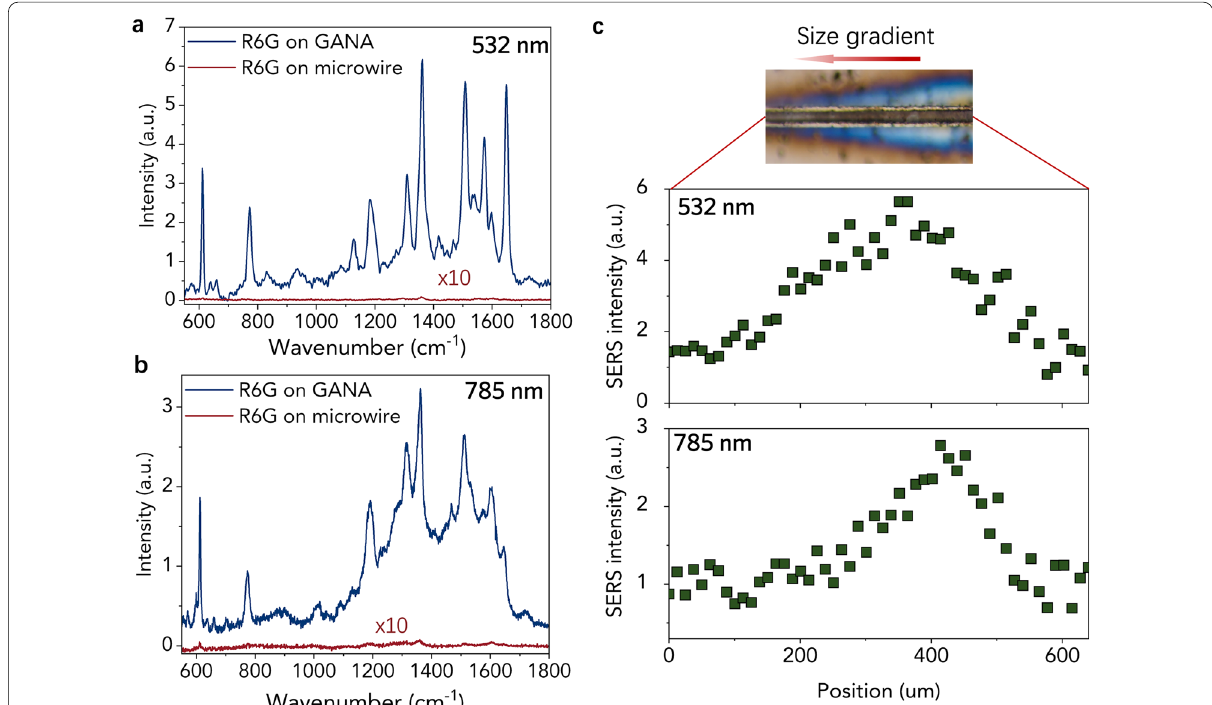
Fig. 5 Typical SERS spectra of R6G on microwire with and without gold GNPA at a 532 nm and b 785 nm laser excitation. c SERS line scan along the size gradient shows the variation of the position-dependent SERS